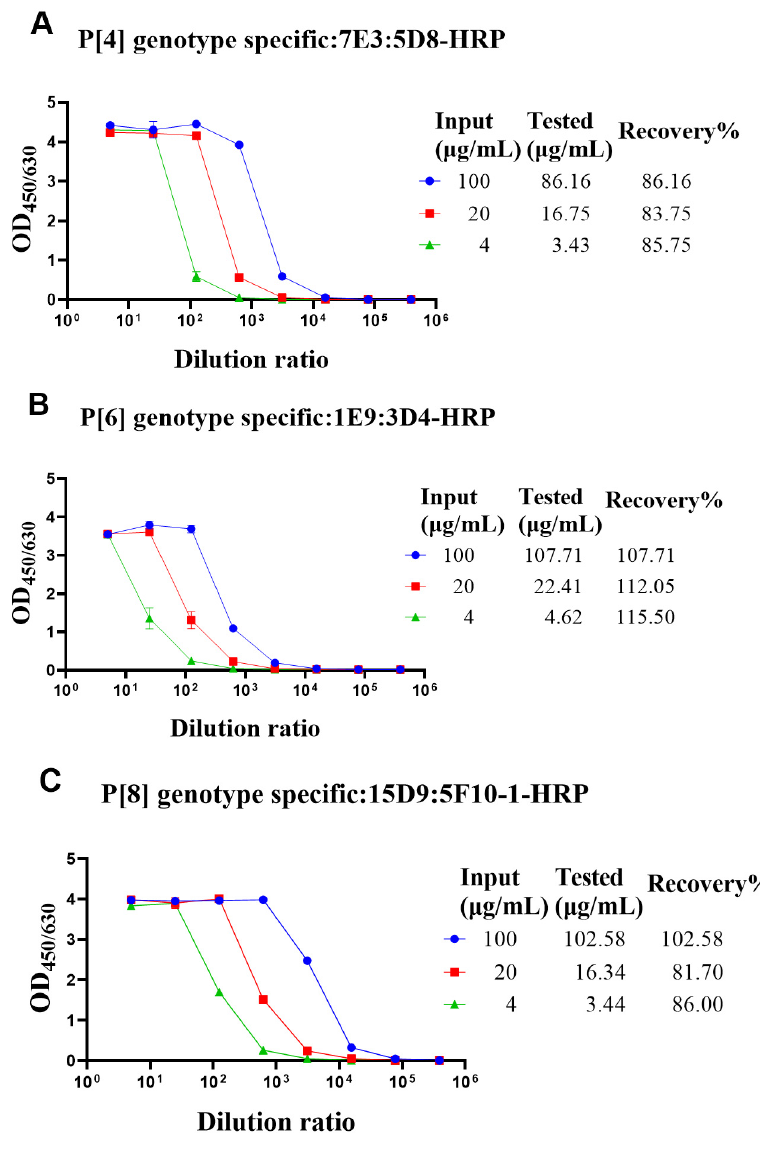
Figure 3. The recovery rate of P[4], P[6], and P[8]-VP4* proteins in E. coli lysate. The purified P[4], P[6], and P[8]-VP4* proteins were added to the supernatant of Bl21(DE3) E. coli lysate to a final concentration of 100, 20, and 4 µ g/mL, respectively, and detected by the corresponding genotype- specific antibody pairs. ( A ) The results detected by P[4]-VP4*-specific mAb pair (7E3: 5D8-HRP); ( B ) the results detected by the P[6]-VP4*-specific mAb pair (1E9: 3D4-HRP); ( C ) the results detected by the P[8]-VP4*-specific mAb pair (15D9: 5F10-1-HRP). All the experiments were performed in three replicates, and the error bars represent the standard deviation of each group. The concentration of each protein was calculated from the corresponding standard curve (Supplementary Figure S2). The recovery rate was calculated according to the formula: VP4* calculated /VP4* theoretical *100%.